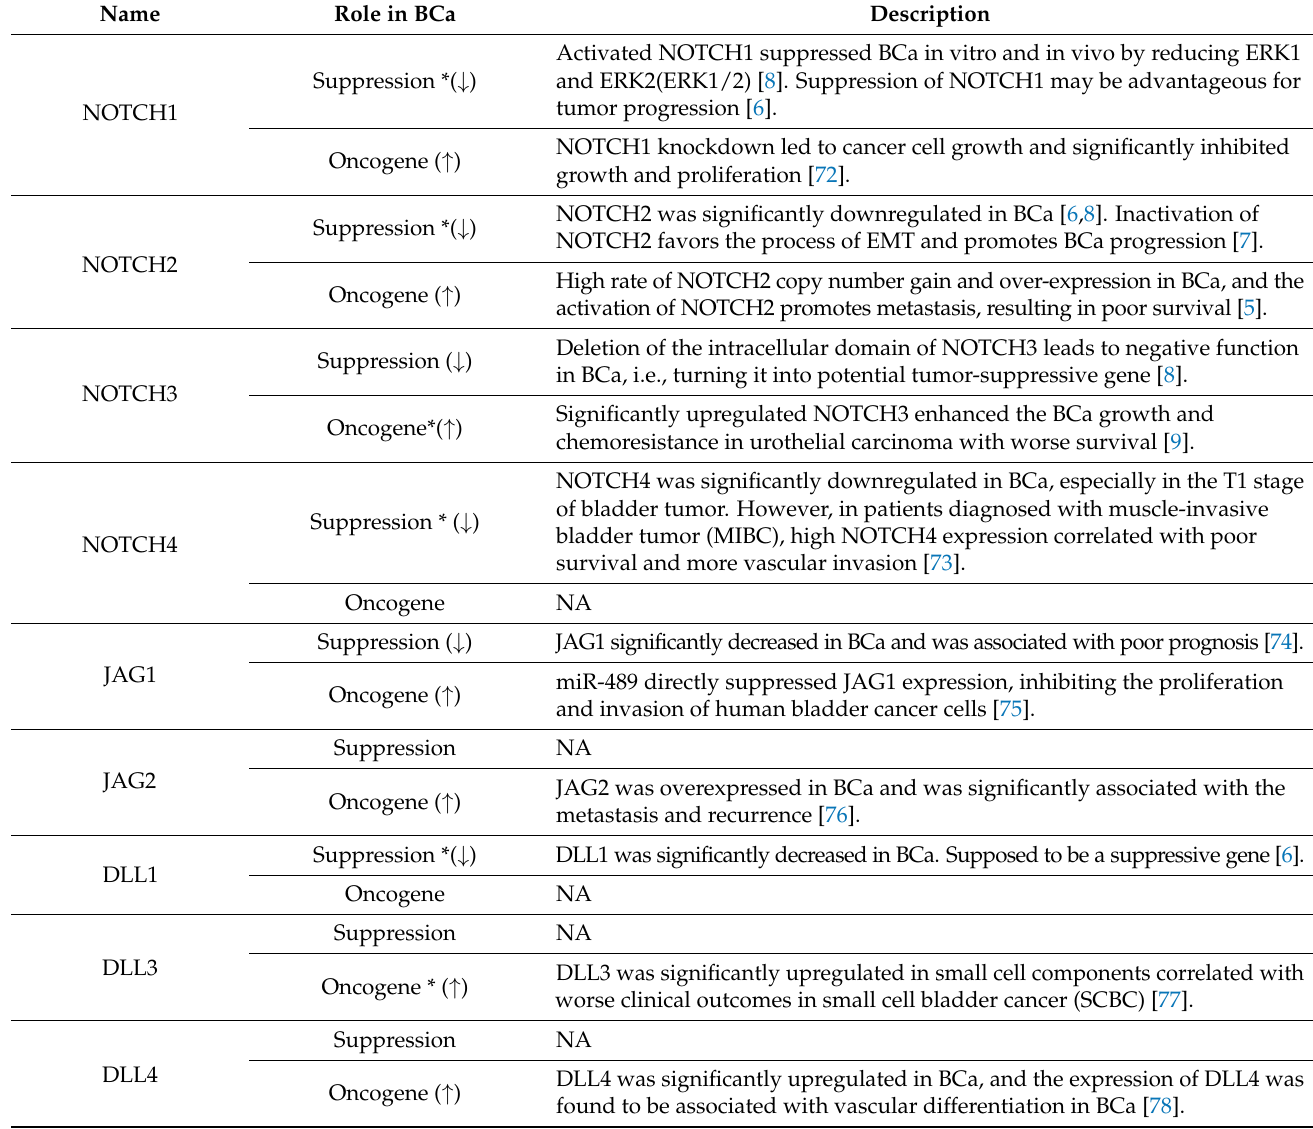
Table 6. The dual role of Notch receptors and ligands in